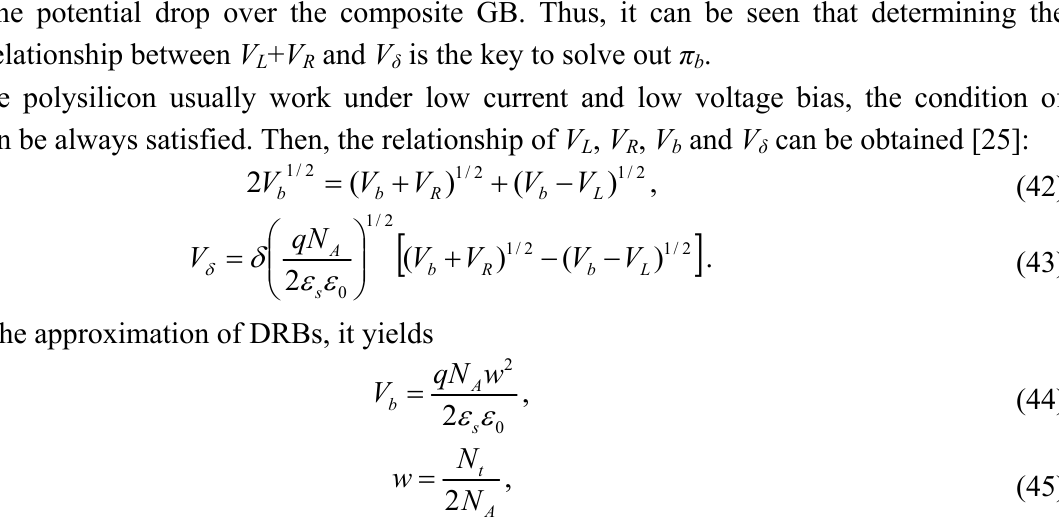
Figure 9. Distribution curve of V